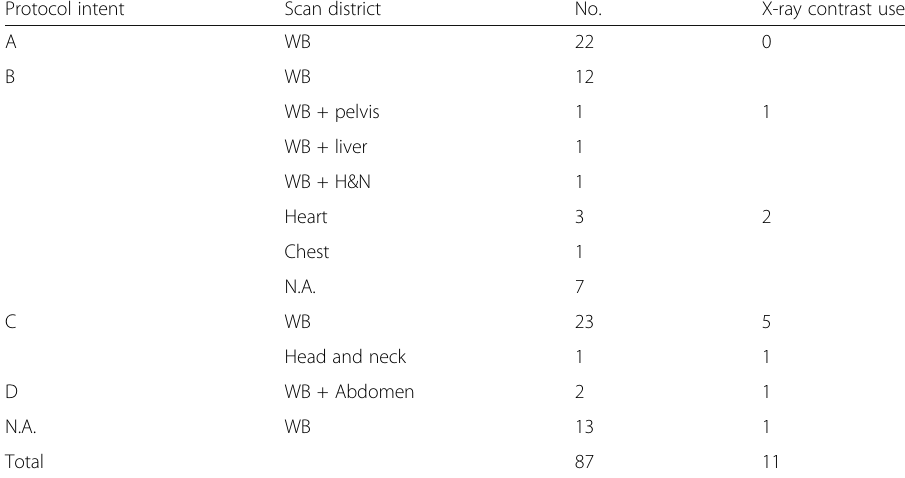
Table 6 Results of CT protocol intent distributions in PET/CT Protocol